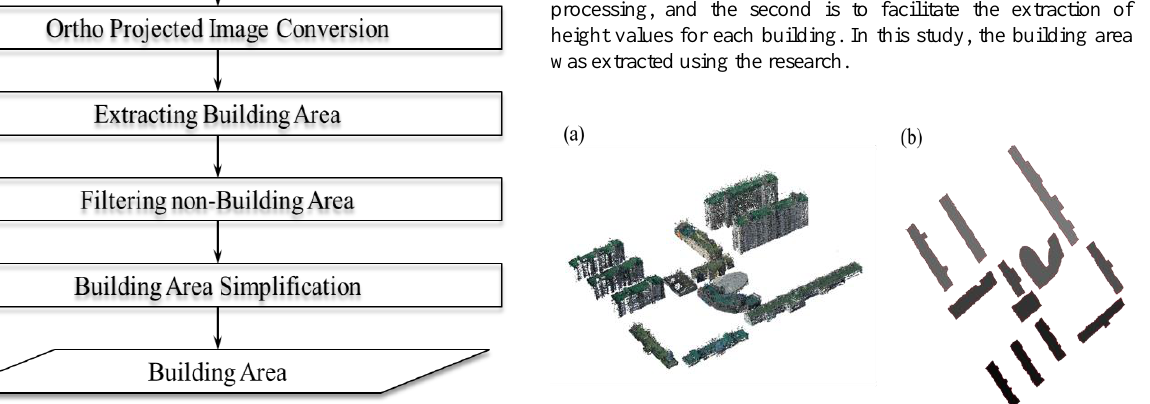
Figure 4. Process of building area extraction.